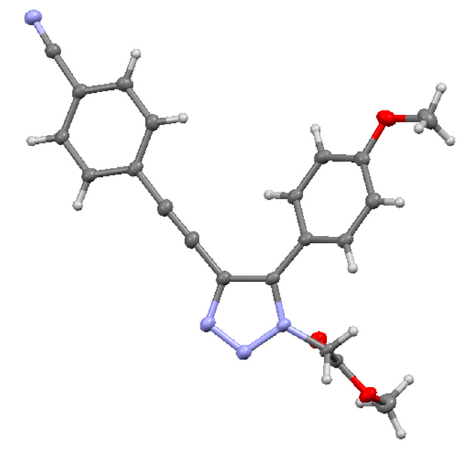
Figure 1. Single ‐ crystal X ‐ ray structure of compound 10d . Figure 1. Single-crystal X-ray structure of compound 10d